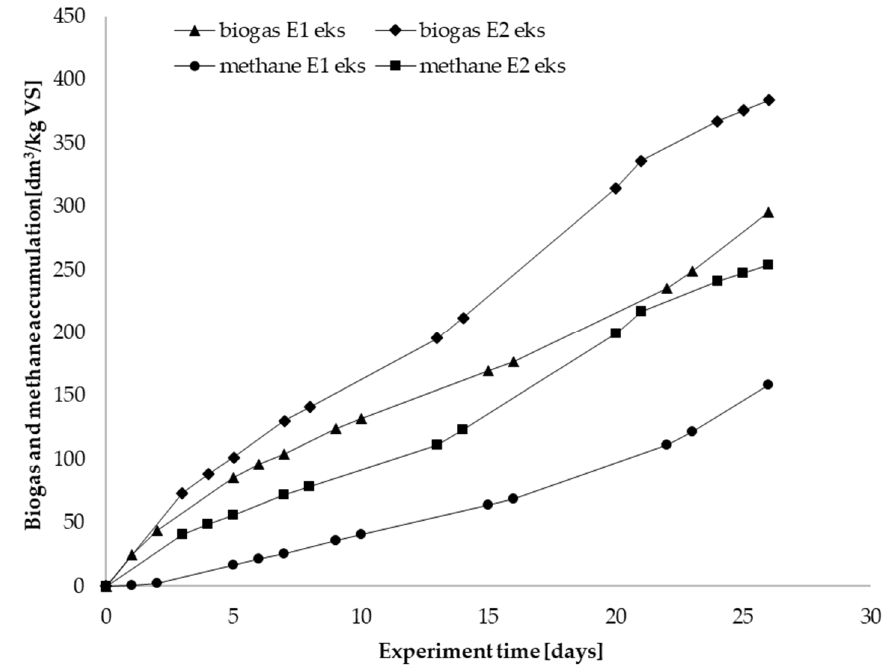
Figure 5. Biogas and methane accumulation curves for experiments E1 and E2.